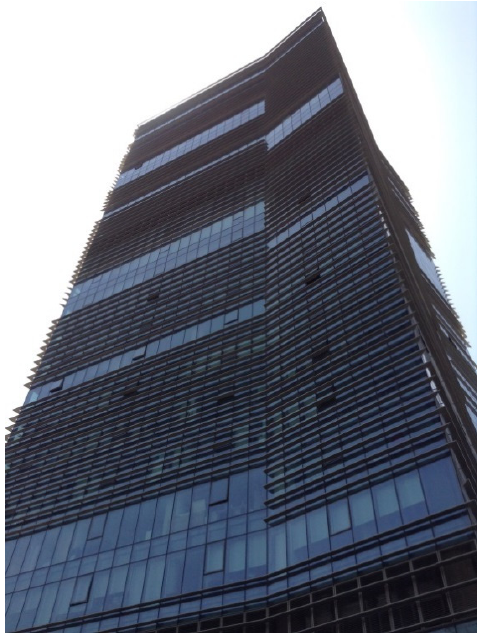
Figure 7. External View of Bayrakl ı Tower. Photograph by Burkay